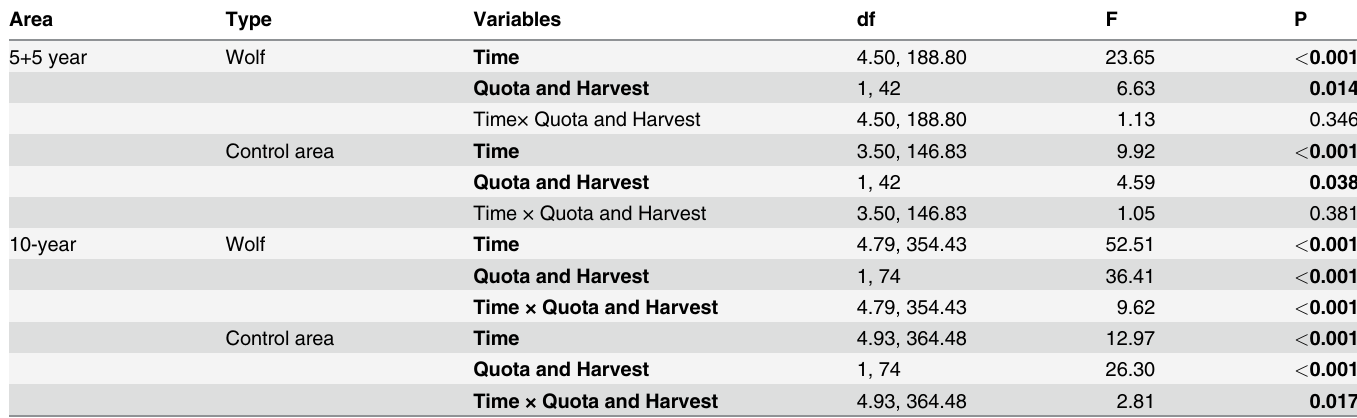
Table 3. Effects of time (ten-year periods) on quotas allocated and actual hunter harvest of adult moose (males and females pooled), using a gen- eral linear model with the repeated measures options.